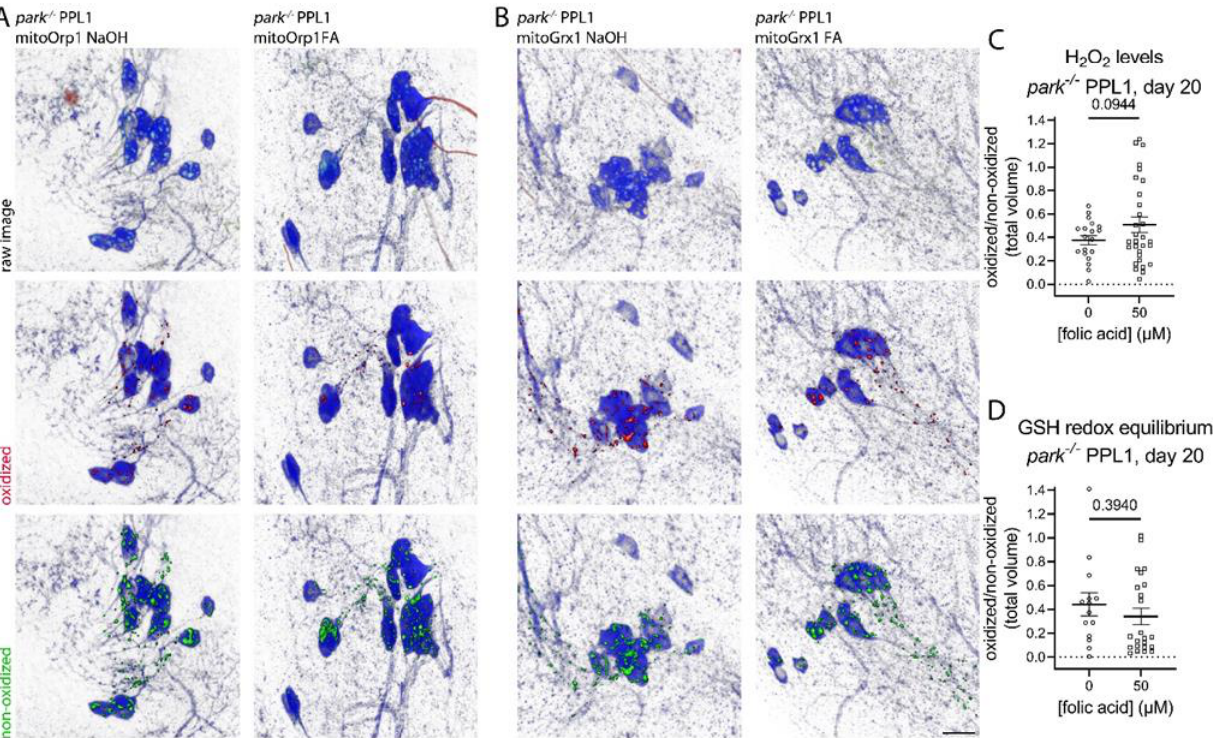
Figure 6. Folic acid administration does not affect PPL1 mitochondrial hydrogen peroxide levels or glutathione redox equilibrium in parkin-null flies on day 20 post-eclosion. Brains were dissected from folic acid-treated park −/− flies expressing ( A ) mito-roGFP2-Orp1 or ( B ) mito-roGFP2-Grx1 on day 20 post-eclosion, and (C, D) ratios of total volumes of oxidized to non-oxidized fluorophore emissions were calculated for one PPL1 region per brain. ( A ) Representative raw images are shown in the top row, where blue indicates tyrosine hydroxylase antibody labeling, and red and green indicate oxidized and non- oxidized roGFP2, respectively. Selected volume “isosurfaces” of oxid ized (red, middle row) and non-oxidized (green, bottom row) ( A ) mito-roGFP2-Orp1 and ( B ) mito- roGFP2-Grx1 above threshold are also shown. Scale bar, 10 µm. ( C , D ) Each data point represents the ratio from one PPL1 region ( n ≥ 23). A Welch’s t test and a Mann – Whitney test were run to determine the effect of folic acid on hydrogen peroxide levels and glutathione redox equilibrium, respectively. Error bars represent standard error of the mean, and p values are reported for each comparison.